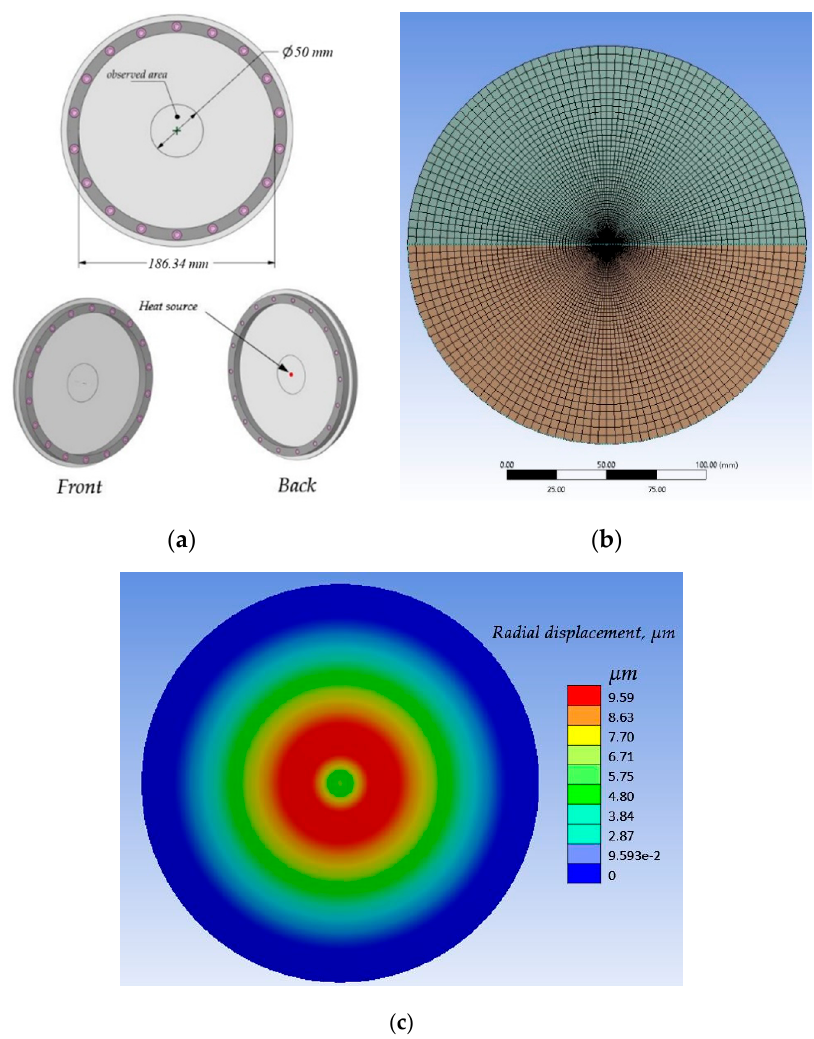
Figure 8. ( a ) The geometrical model, ( b ) used mesh in the simulation, and ( c ) results of the simulation by finite element analysis . by finite element